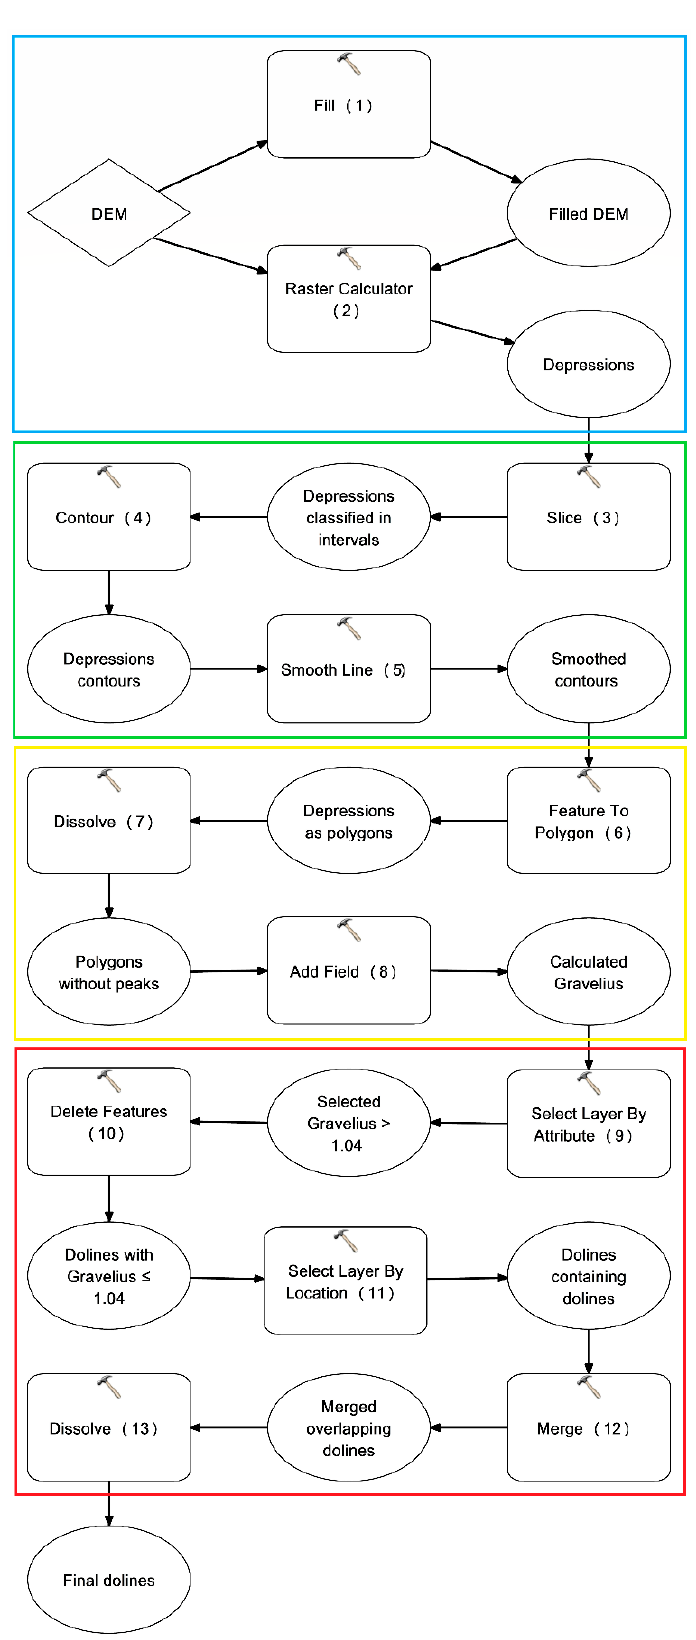
Figure 4. Workflow and ArcGIS tools for the multidepth threshold approach (MDTA) method divided by stages: Depression estimation (blue), depression classification (green), vectorization (yellow) and filtering (red).